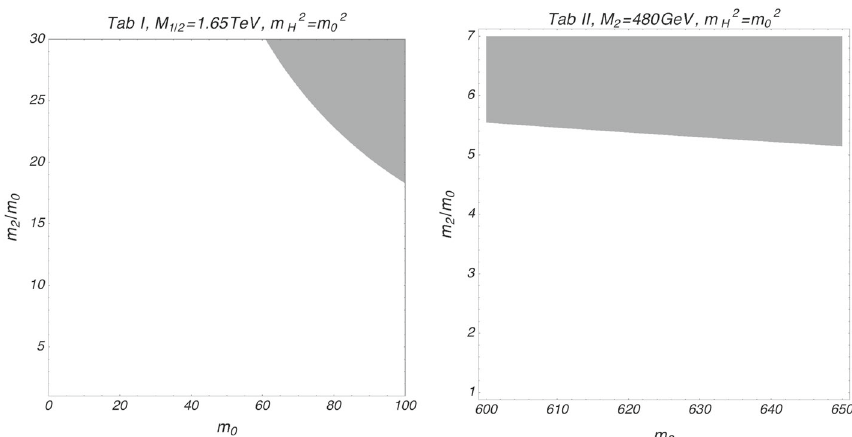
Fig. 8 The FCNC constraints for the mass splitting between the first two generation squarks. The gray shaded regions are excluded by (cid:5) K